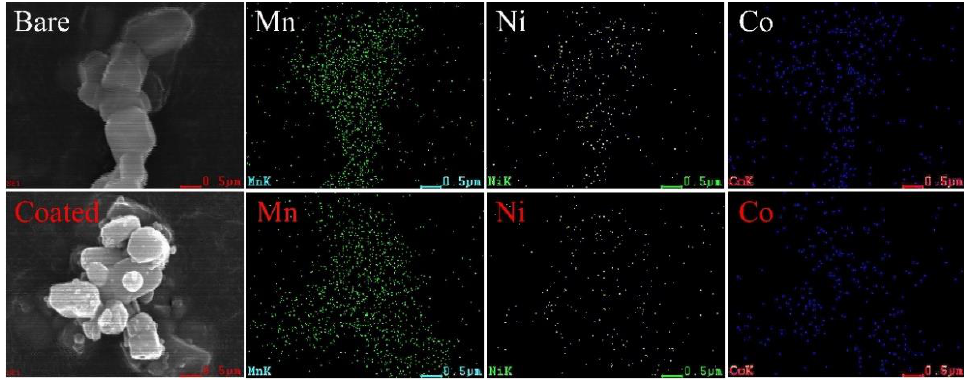
Figure 2. FESEM results for the ( a , b ) bare and ( c , d ) MnO 2 -coated LTMO particles.